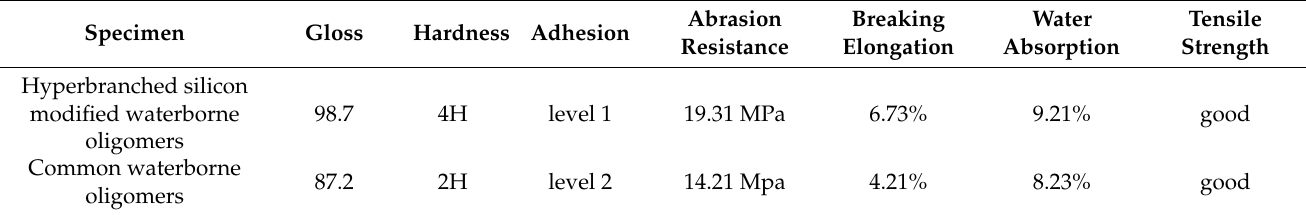
Table 5. The performance of light cured coating